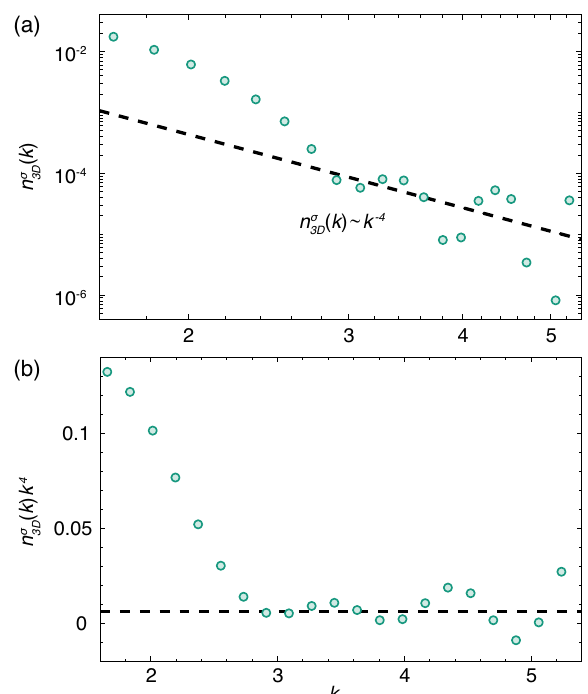
FIG. 7. Extracting the contact from the 3D momentum dis- tribution. (a) 3D momentum distribution of a SU(6) gas is obtained from the column-integrated distribution (the same data in Fig. 1 in the main text) using an inverse Abel transform. The 3D density in high-momentum k follows the power law n σ ð k Þ ∼ k − 4 , which gives the contact C ¼ 0 . 007 ð 1 Þ with 3 D 95% confidence. (b) The contact is extracted from the tail of ð k Þ k 4 for 3 < k < 4 . The mean (one standard the term n σ 3 D deviation in parentheses) is 0.006(3). The value of the contact extracted from the 3D momentum distribution is in agreement with the result of our method 0.0067(5) but has a larger uncertainty.